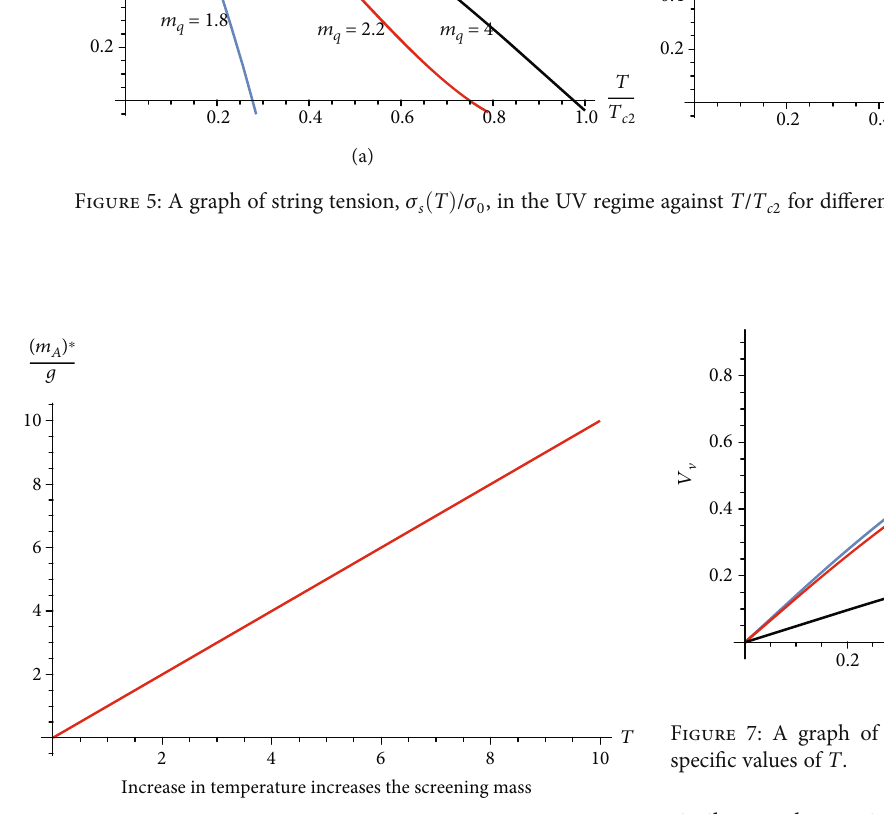
Figure 6: A graph of fl uctuating gluon mass m ∗ temperature T .